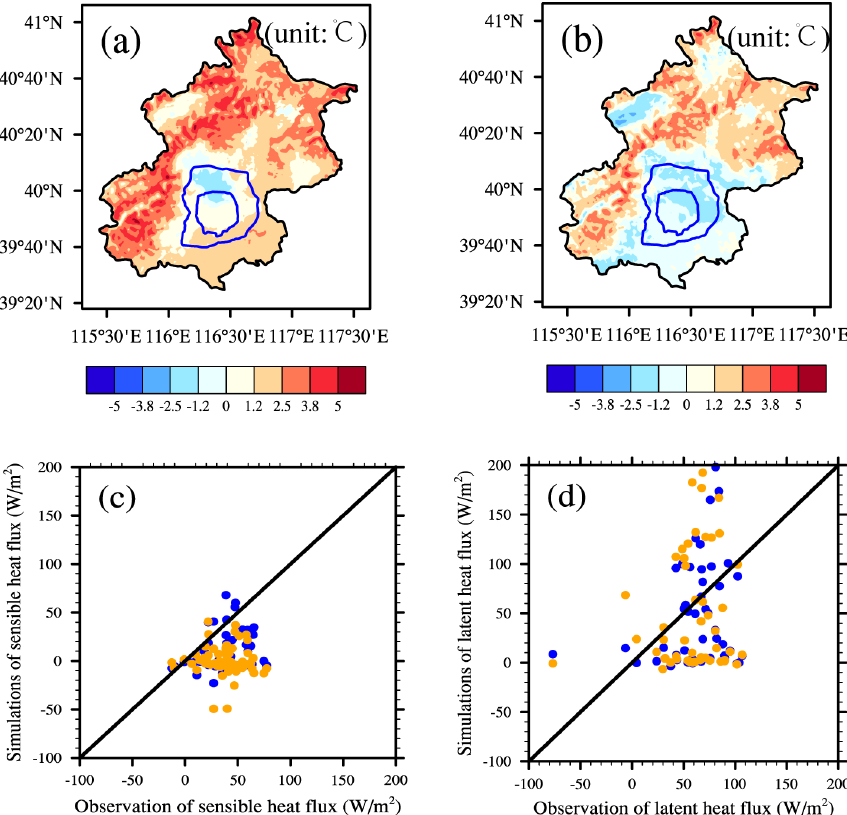
Figure 8. Comparisons between WRF simulations with and without water usage schemes. (a) Temperature difference between WRF model simulations without urban water usage scheme and CLDAS. (b) Temperature difference between WRF model simulations with urban wa- ter usage scheme and CLDAS. (c) Sensible heat flux comparisons between station observation and WRF simulation. (d) Latent heat flux comparisons between station observation and WRF simulation. Blue dots are the raw simulation results, and orange dots are the simulation results with urban water usage schemes.